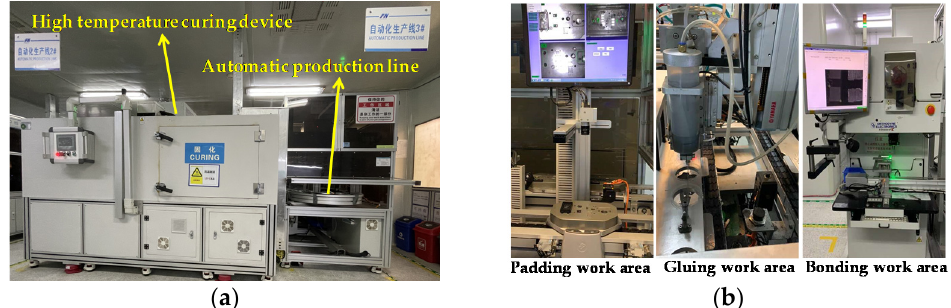
Figure 1. MEMS pressure-sensor packaging equipment. ( a ) High-temperature curing device and automatic production line. ( b ) Mechanical devices of automatic-production-line work area.